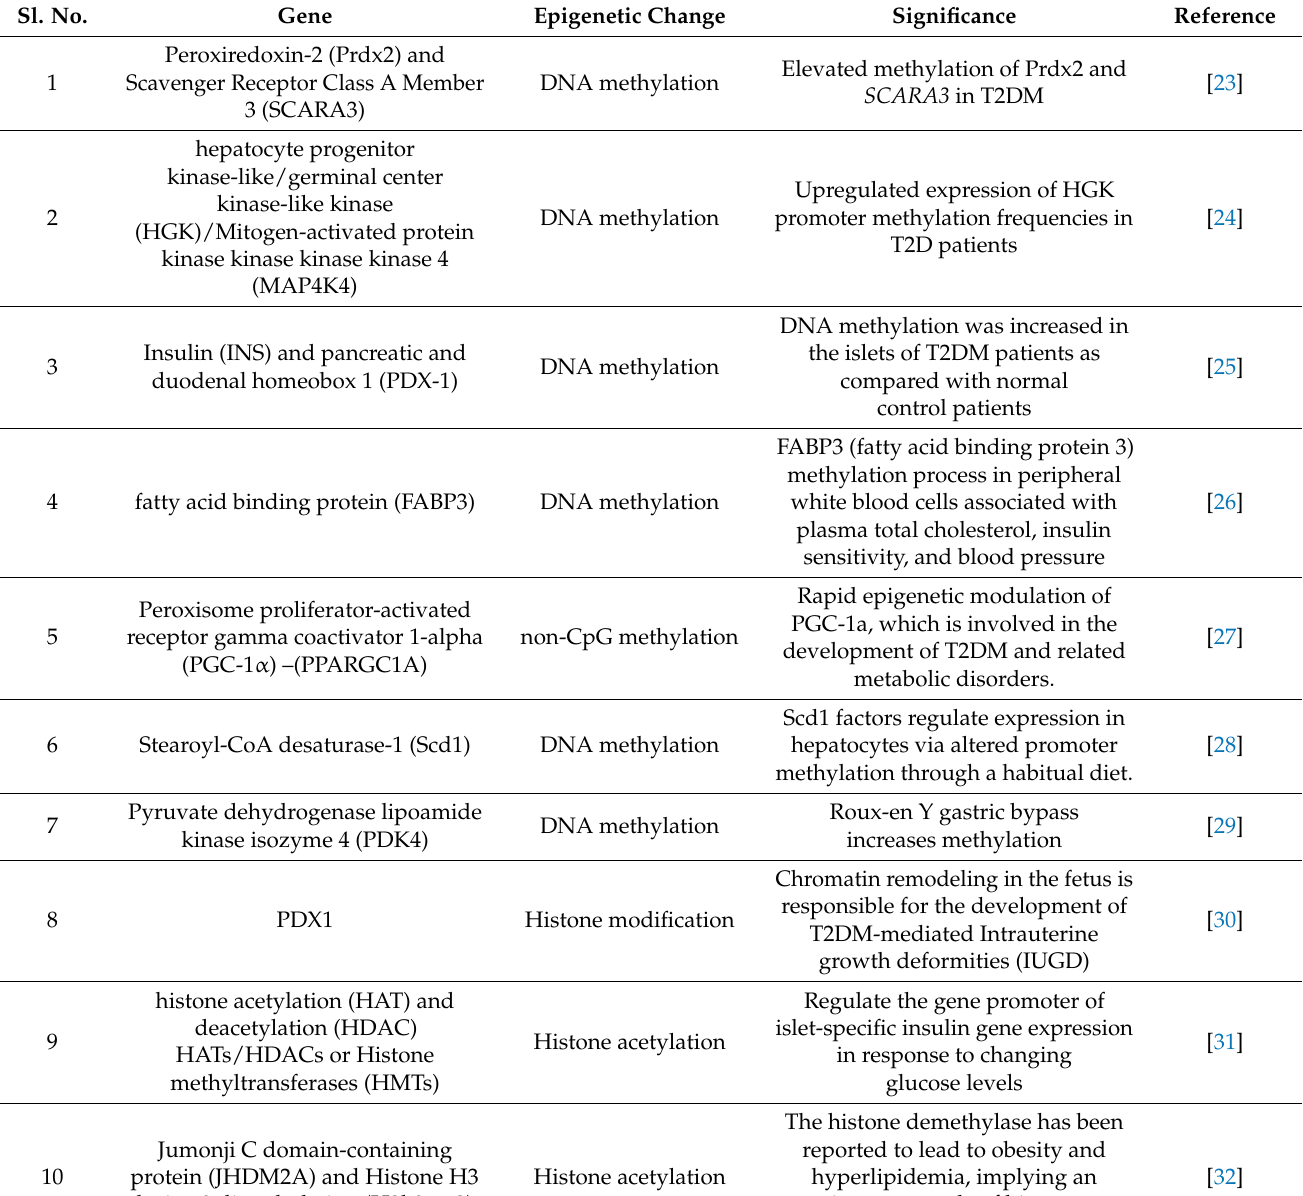
Table 1. Epigenetic modifications of T2DM-associated